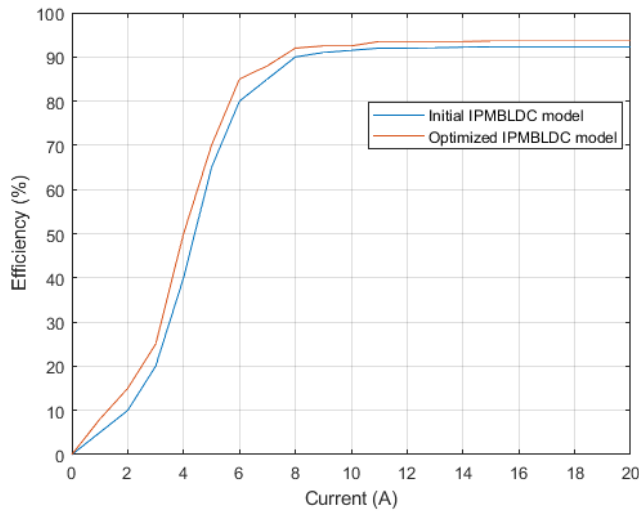
Figure 17. Efficiency vs. current of initial and optimized IPMBLDC motor